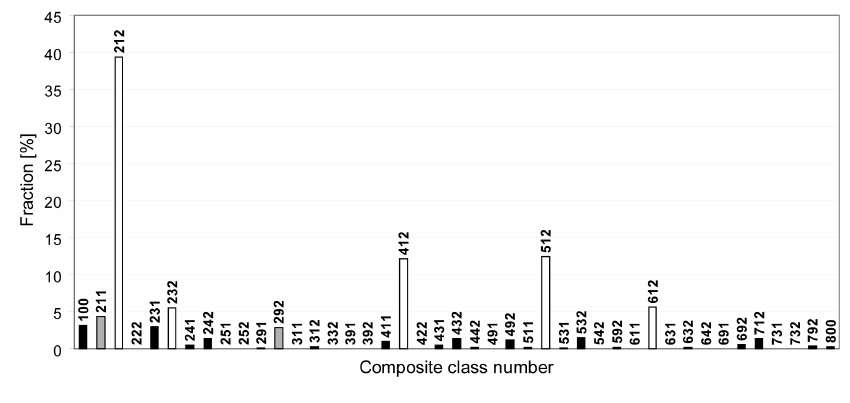
Fig. 4. Fractions [%] of the composite classes (combining land cover, topsoil and subsoil data) contained within the SMOS pixel around node 2002029. Classes selected for the placement of network stations with fractions > 5% (212, 232, 412, 512 and 612) are in white, the most frequent classes with high fraction of organic material (humus) in topsoil (292)/clay in subsoil (211) are in grey, and the remaining (not considered) classes are in black. Table 4. Selected composite classes for the SMOS pixel around Discrete Global Grid node 2002029: class number, land cover, top- and subsoil descriptions, respective class fractions [%], corresponding recalculated fractions after redistribution of class 412 and omitting all other classes [%], numbers of allocated network stations, and descriptive code (A=agriculture, F=forest, H=heath, S=sand, L=loamy sand, O=organic material/humus). Class Redist. Nr. Descr. Land cover Topsoil Subsoil Fract. nr. fract. stats. code